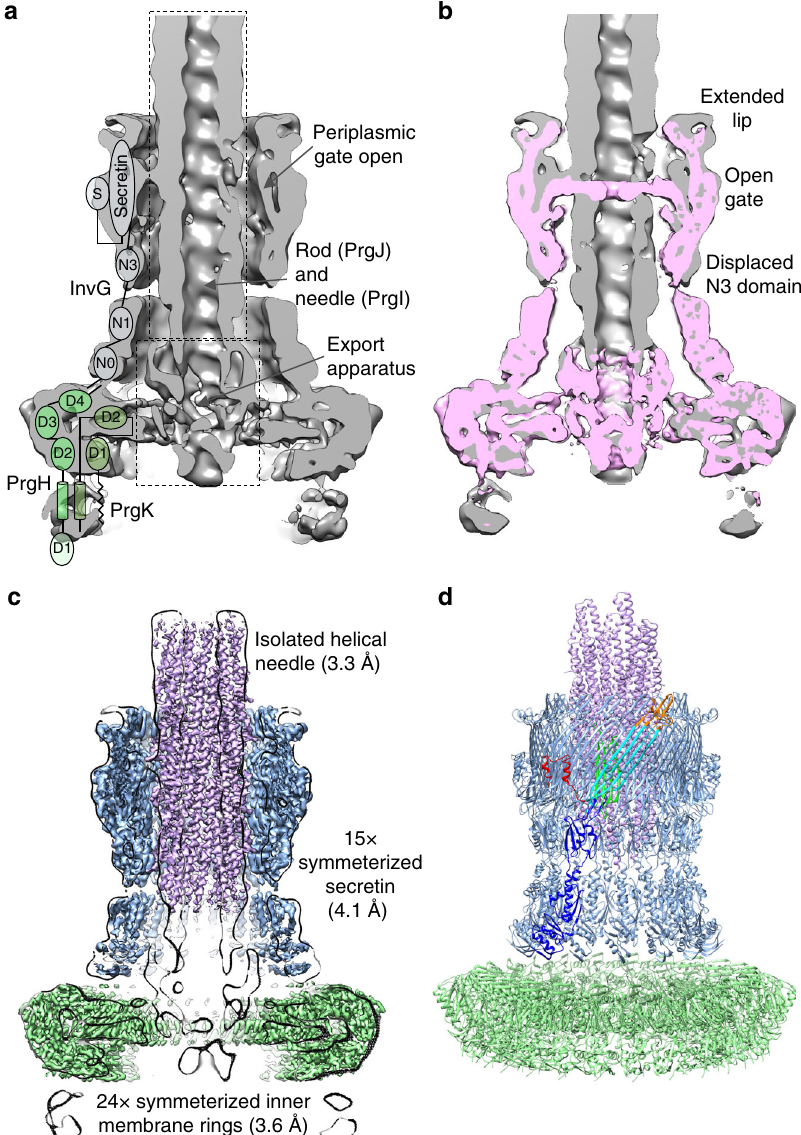
Fig. 1 Cryo-EM structures of the injectisome needle complex and isolated needle. a Needle complex C1 reconstruction (low pass fi ltered from 7.4 Å reconstruction to highlight overall features) cut away at the mid-section. The domain annotation of PrgH, PrgK, and InvG is overlaid on the left. Boxed regions indicate the periplasmic region of the export apparatus and the rod/needle fi lament. b Central slice view of needle complex reconstruction (gray) overlaid with the 6.3 Å basal body reconstruction (EMD-8400) (pink). c Reconstructions for the 24-fold averaged IM rings (green; 3.6 Å resolution), the 15-fold averaged secretin (blue; 4.1 Å resolution) and the isolated needle (magenta; 3.3 Å resolution). High-resolution reconstructions overlaid on C1 reconstruction shown as central slice (black). The needle was fi t into the needle complex C1 map using Chimera and agrees well with the wider part of the needle complex fi lament. d Re fi ned structures for InvG 34 – 557 (blue), PrgH 171 – 364 (green), PrgK 20 – 203 (green), and PrgI 3 – 80 (magenta). One monomer encompassing InvG 34 – 557 is colored according to structural domains: N0-N3 domains (blue); outer β -sheet (cyan); inner β -sheet (green); secretin domain lip (orange); S domain